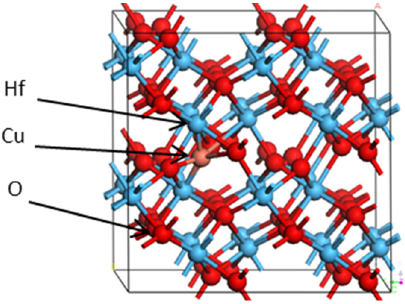
Figure 1. Supercell crystal structure of HfO 2 (red, blue, and brown spheres represent O ions, Hf ions, and Cu ion, respectively).